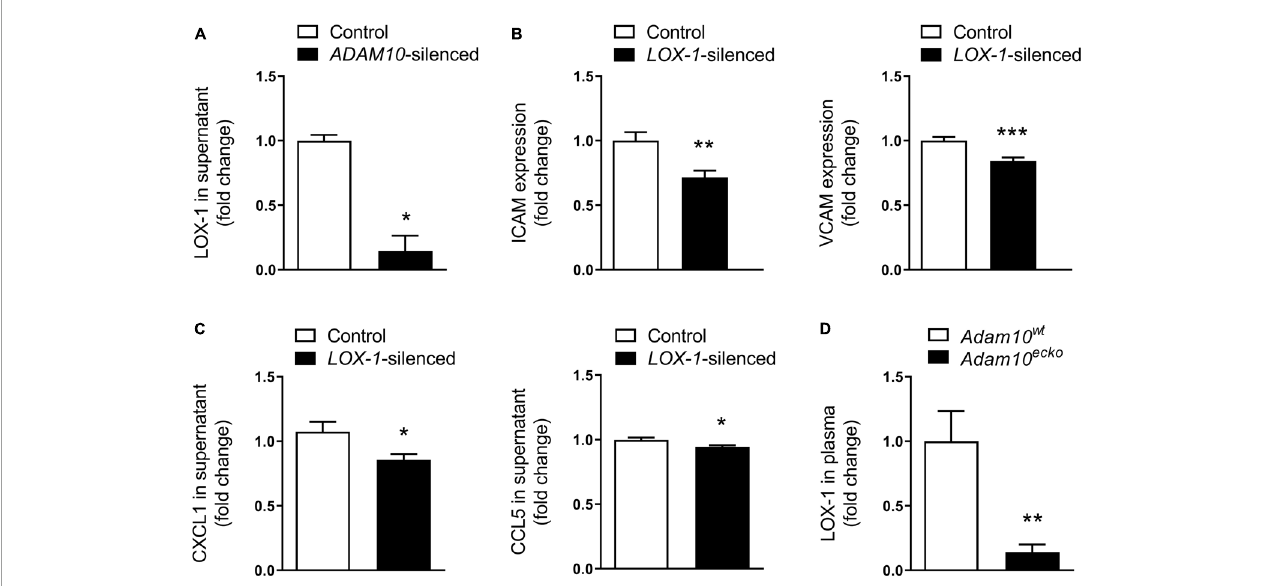
FIGURE6 LOX-1 shedding is a key mediator in the observed pro-inflammatory and pro-atherogenic effects by endothelial ADAM10. (A) Quantification of soluble LOX-1 in supernatant of control and ADAM10 silenced HCAECs stimulated with 25 µ g/ml oxLDL for 24 h, measured by ELISA ( n = 3). (B) Surface expression of ICAM and VCAM, measured by flow cytometry in control and LOX-1 silenced HCAECs (all conditions were additionally ADAM10 silenced) stimulated with or without 25 µ g/ml oxLDL for 24 h ( n = 9). (C) Quantification of soluble CCL5 and CXCL1 in supernatant of control and LOX-1 silenced HCAECs (all conditions were additionally ADAM10 silenced) stimulated with 25 µ g/ml oxLDL for 24 h, measured by ELISA ( n = 15–22). (D) Plasma LOX-1 levels in Adam10 ecko and Adam10 wt mice ( n = 11–14). * p ≤ 0.05; ** p ≤ 0.01; *** p ≤